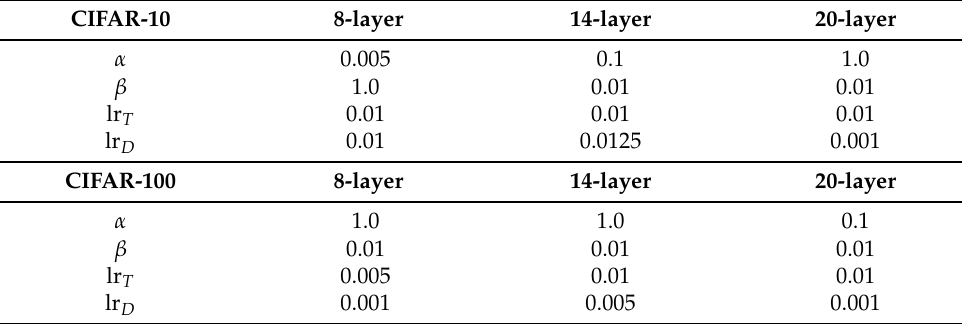
Table 2. Hyper-parameters in experiments for training datasets and target